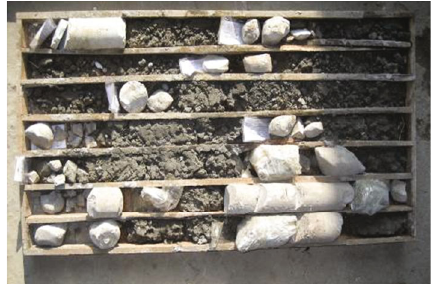
Figure 5: Back fi ll in GZK4